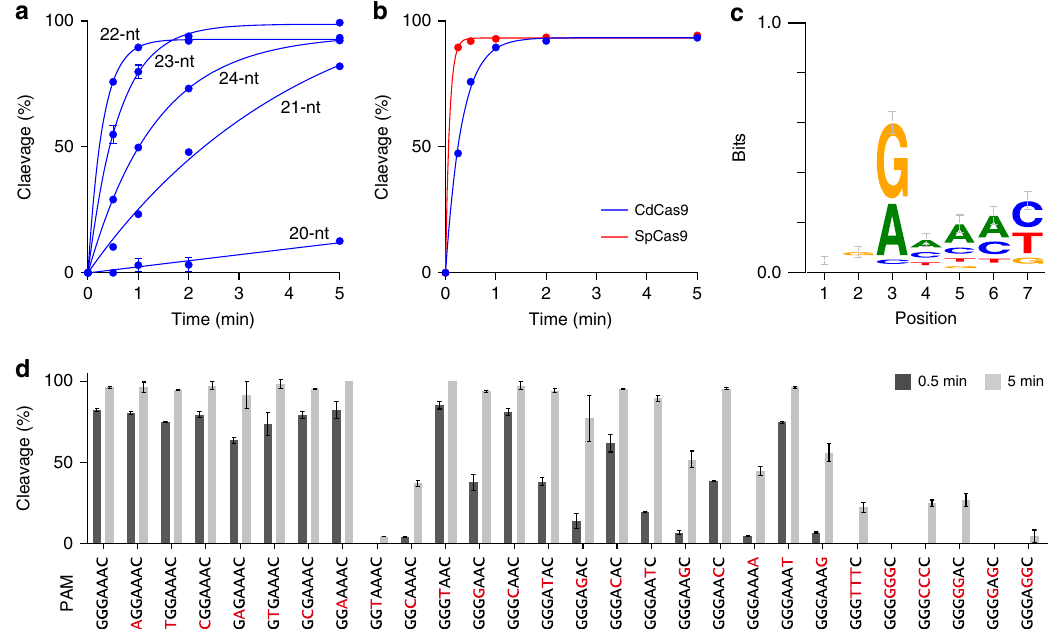
Fig. 1 In vitro cleavage activities of Corynebacterium diphtheriae Cas9 (CdCas9). a In vitro cleavage activities of CdCas9 with the 20 – 24-nt guide single- guide RNAs (sgRNAs). The linearized plasmid target bearing the GGGAAAC protospacer adjacent motif (PAM) was incubated with the CdCas9-sgRNA complex at 37 °C for 0.5, 1, 2, and 5 min, and the cleavage products were then analyzed by a MultiNA microchip electrophoresis system. b In vitro cleavage activities of CdCas9 and Streptococcus pyogenes Cas9 (SpCas9). CdCas9 and SpCas9 were programmed with their 22- and 20-nt guide sgRNAs, respectively. The linearized plasmid target bearing the GGGAAAC PAM was incubated with the Cas9-sgRNA complex at 37 °C for 0.25, 0.5, 1, 2, and 5 min. c Motif obtained from the in vitro PAM identi fi cation assay. d PAM preference of CdCas9. The linearized plasmid targets bearing the different PAMs were incubated with CdCas9-sgRNA22 at 37 °C for 0.5 and 5 min. Error bars represent s.d. from n = 3